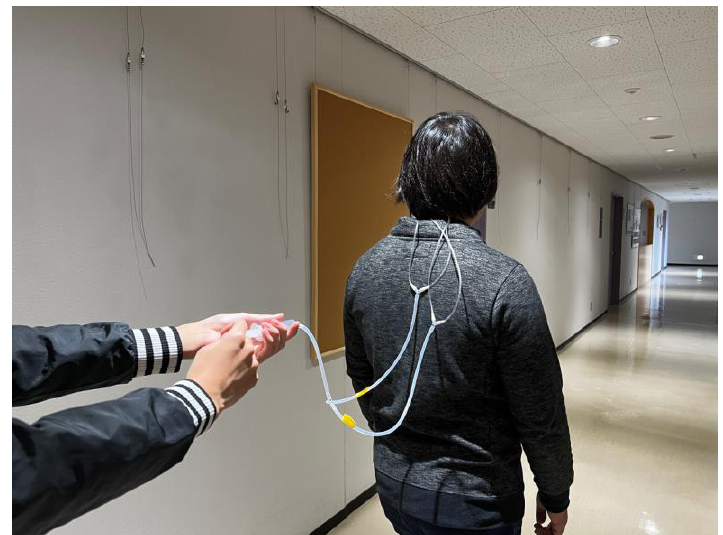
Figure 8. A participant in the user study.